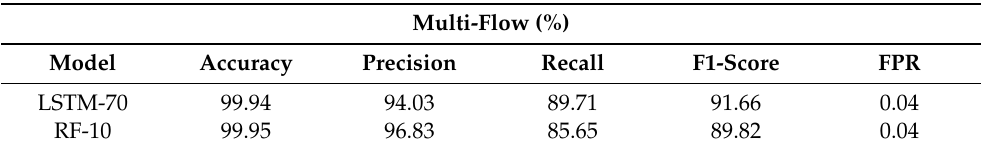
Figure 9. Evolution of the f1-score for the LSTM, RF and MLP models as the window size increase. Table 10. Comparison between the f1-scores of LSTM-70 and RF-10.